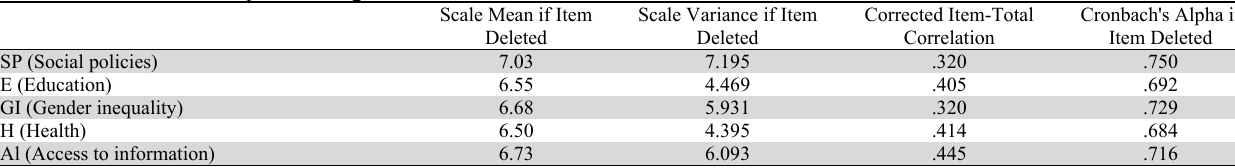
Results of Cronbach’s Alpha Testing of Attributes